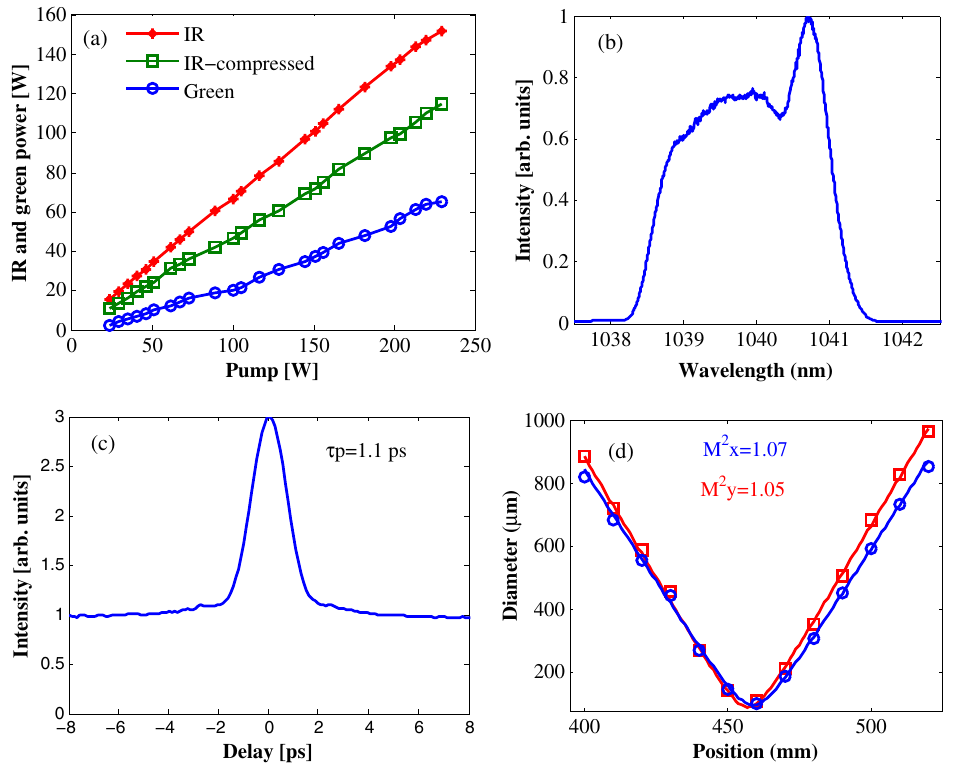
FIG. 9. (a) Compressed IR output and green power versus pump power; (b) optical spectrum of the amplified pulses at 150 W; (c) AC signal; and (d) M 2 measurement results at 85 W compressed IR power. a grating pair. At the maximum pump power, 110 W of IR power is obtained with an overall efficiency of 74%. The PER of the compressed pulses is > 20 dB, and the M 2 values in horizontal and vertical directions are less than 1.1